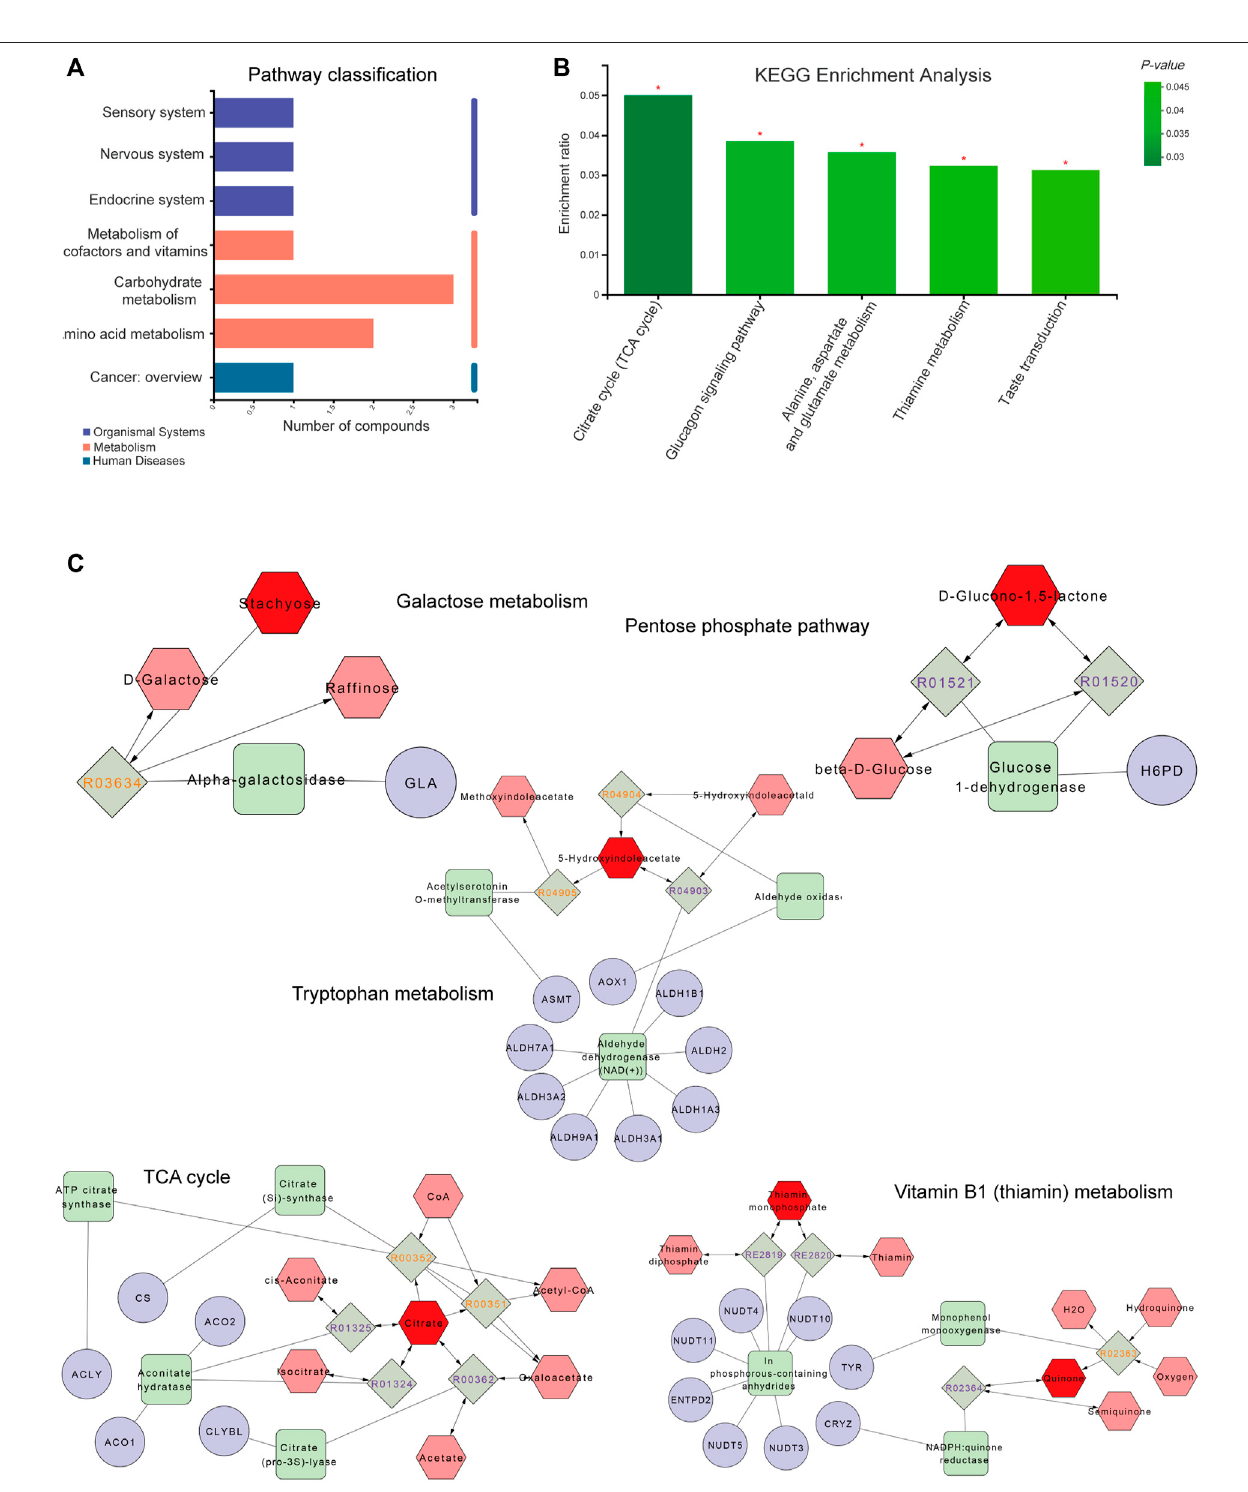
FIGURE5| Metabolitepathwayanalysisandnetworks. (A) Theordinateandabscissarepresentthesecondaryclassi fi cationofaKEGGmetabolicpathwayandthe amount of related metabolites, respectively. (B) The abscissa and ordinate represent the pathway ’ s name and enrichment rate, respectively. (C) Compound-reaction- enzyme-gene network. Red hexagons, gray diamonds, green rectangles and purple circles are active compounds, reactions, enzymes and genes, respectively. * p < 0.05, ** p < 0.01 and *** p < 0.001.